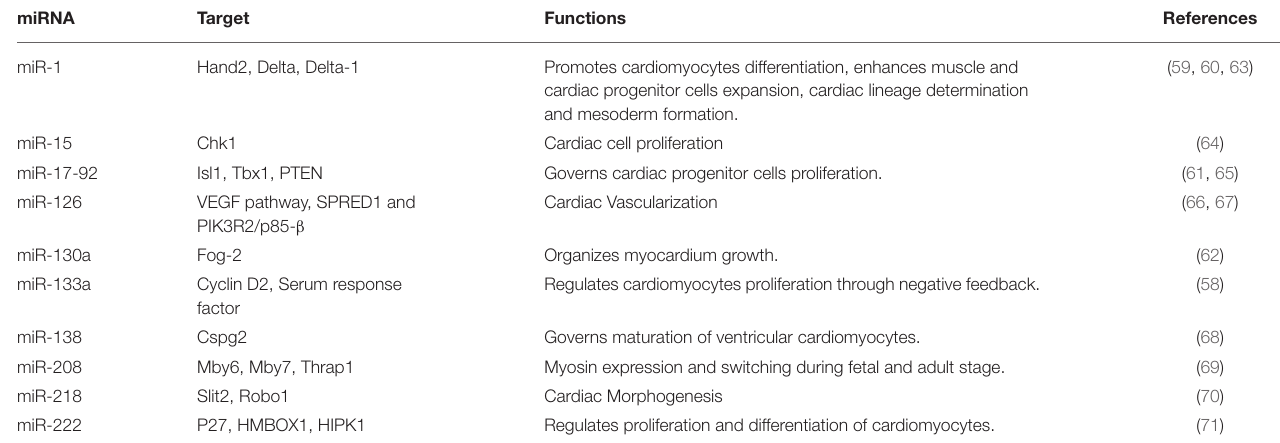
TABLE 1 | miRNAs involved in cardiac development. miRNA Target